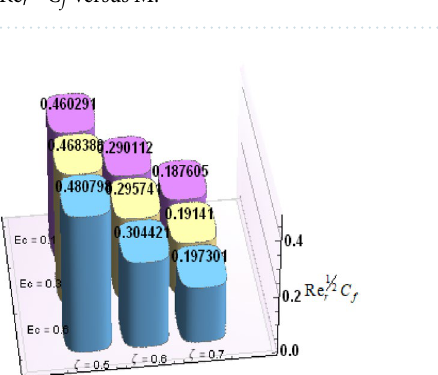
Figure 13. Bar chart representation of Skin friction coefficient and Nusselt number for different parameters using Mathematica 10 software available at (https:// softa sm. com/ wolfr am- mathe matica- 10-4- full- crack/). Re1 /2 r C f versus M.